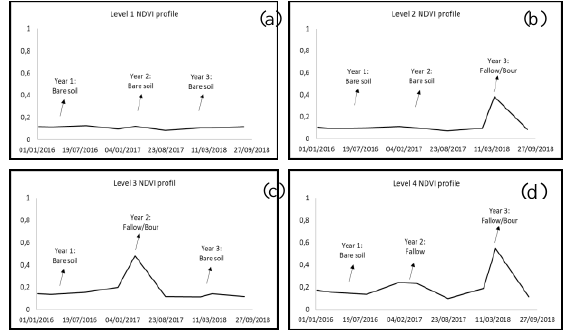
Figure 6. 2016-2018 continuous NDVI profiles reflecting land- cover dynamic of representative samples from the different levels’ combinations. (a) sample from level 1 lands; (b) sample from level 2 lands; (c) sample from level 3 lands; (d) sample from level 4